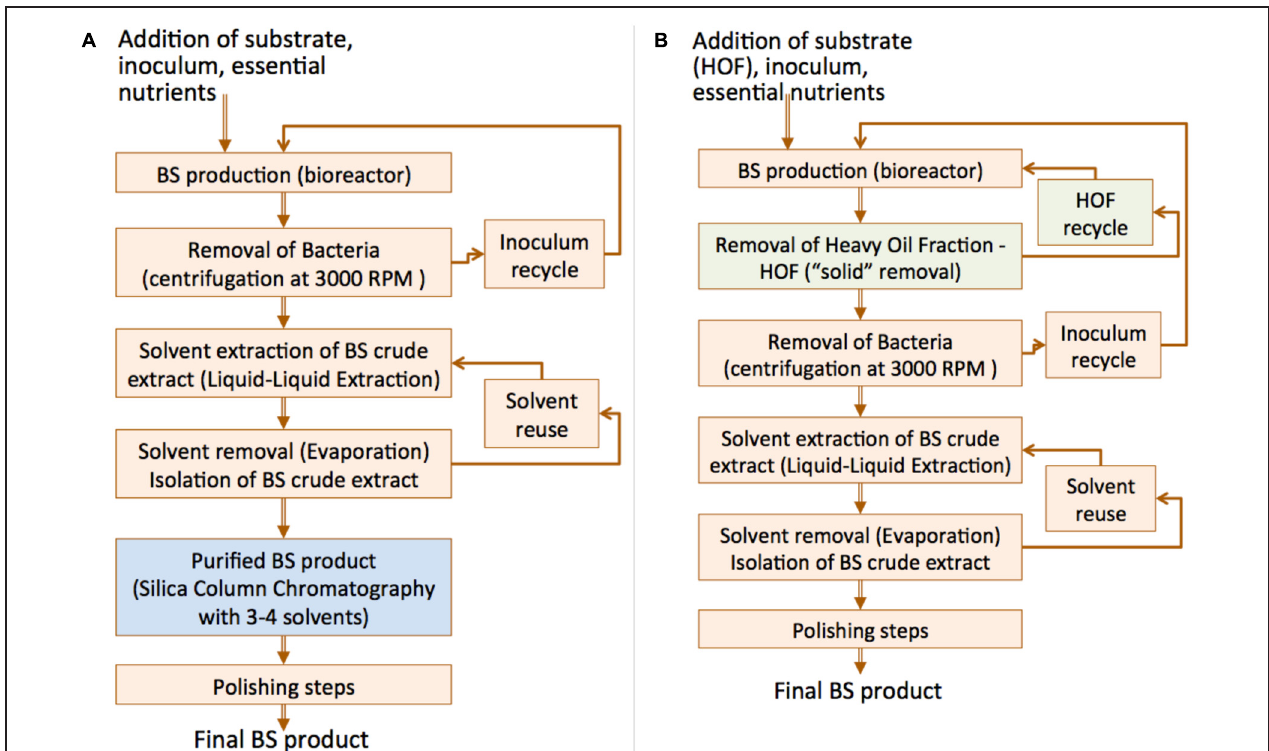
FIGURE 9 | Comparative process flowchart for BS production: (A) Typical substrates (i.e., crude oil) that cannot be readily removed from the culture broth and hence the chromatographic separation step is required; (B) Use of HOF (rich in asphaltenes) which can be readily removed from culture broth, overcomes the requirement for chromatographic separation